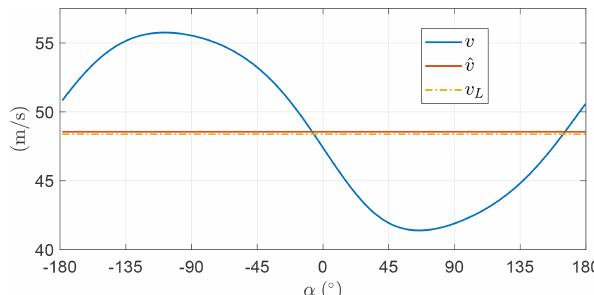
Figure 21. Optimal shaft power production normalized with the analytical expression of thrust power as a function of C D A